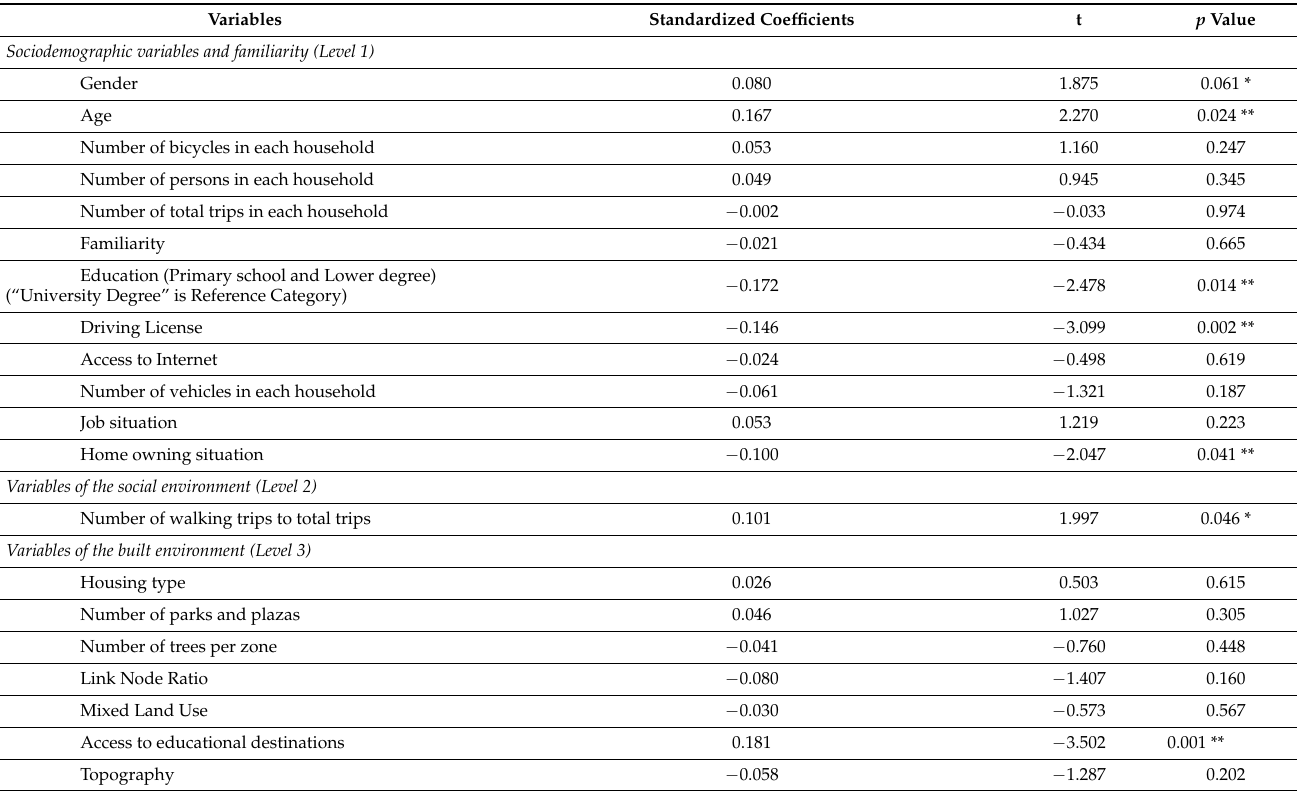
Table 5. The results of hierarchical multiple regression analysis for predicting walking to the educa- tional destinations (N =